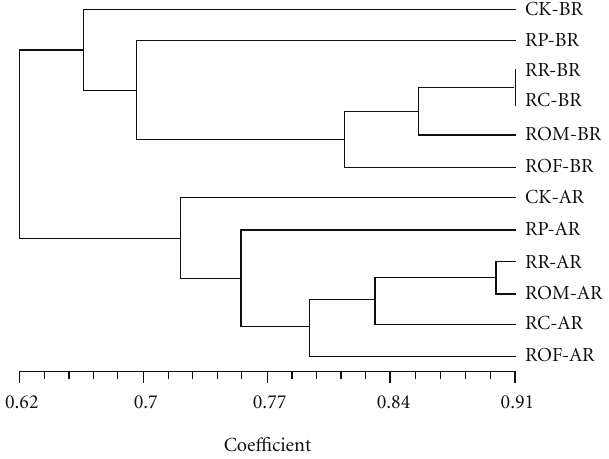
Figure 3: UPGMA dendrogram generated from all representative T-RFLP sample profiles. The scale indicated the coe ffi cient between soil from paddy-upland crop rotation systems sampled at posthar- vest (AR) and pretransplanting (BR); Abbreviations: CK, rice-fallow phase; RR, rice-ryegrass; RP, rice-potato, with rice straw as mulch; RC, rice-Chinese milk vetch; ROM, rice-oilseed rape with burned straw return after harvest; ROF, rice-oilseed rape with fresh straw return as mulch at